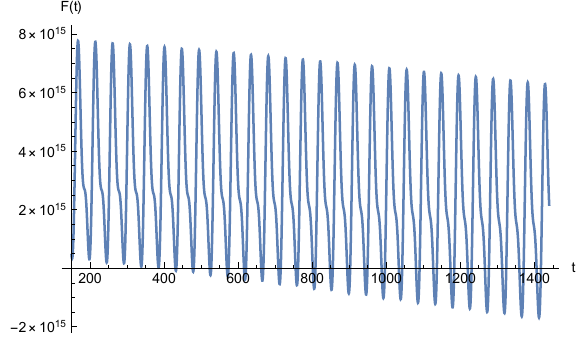
Fig. 6 Visibility Intervals Between CFESAT and MTI For 24-H